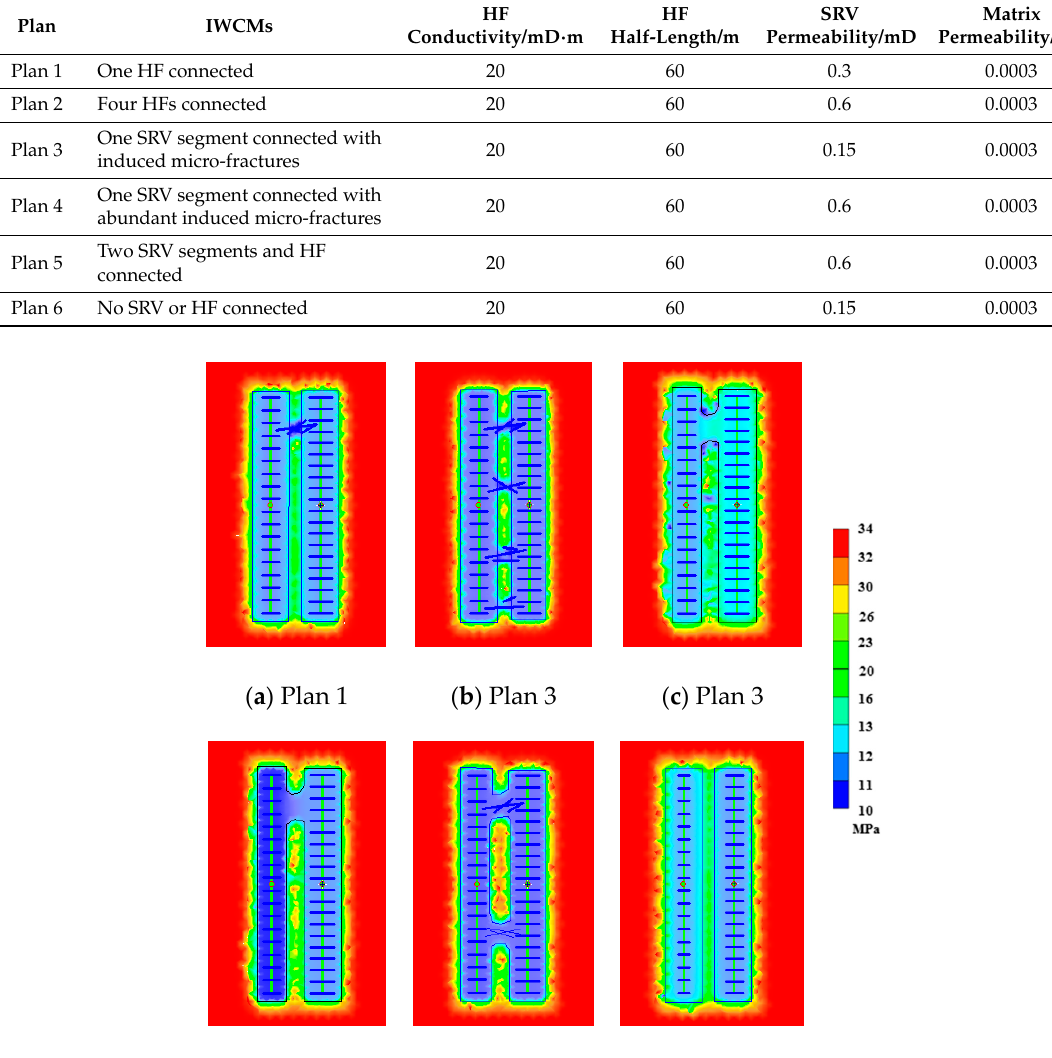
Figure 7. BHP changes during production and shut-in of L2 well. Through analyzing the pressure recovery curve of each plan in Figure 8, we get the following understanding. (1) the interference degree comes from neighboring wells in each plan is compared based on the fall magnitude in the later part of the pseudo pressure derivative curve (PPDC): Plan 2 > Plan 6 > Plan 4 > Plan1 > Plan 5 > Plan 3; (2) When HFs or SRV’s induce micro-fractures is in rich, it first experience a brief stratum-fracture bilinear flow (the slope of the pseudo pressure derivative curve is close to 1/4), and then it converts to formation linear flow (the slope of the pseudo pressure derivative curve is close to 1/4), late-stage well interference causes the pressure curve to drop. When induced micro-cracks are not abundant, they mainly experience formation linear flow, and the characteristics of later well interference are not obvious. In summary, BHP changes are affected by both the fracturing effect of the well and interference from neighboring wells. When the fracturing effect of the well is good, and it is connected with the